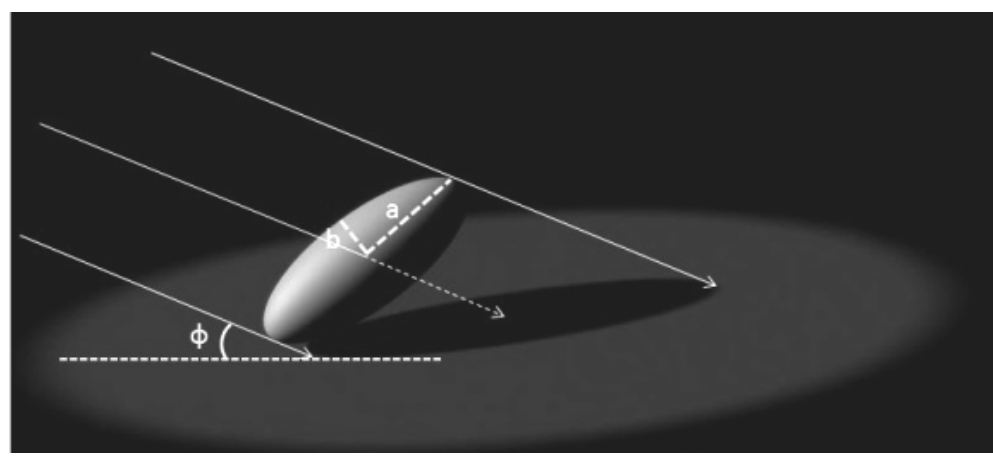
Figure 1. Schematic diagram to illustrate the shadow area calculation for ellipsoid (created based on Campbell